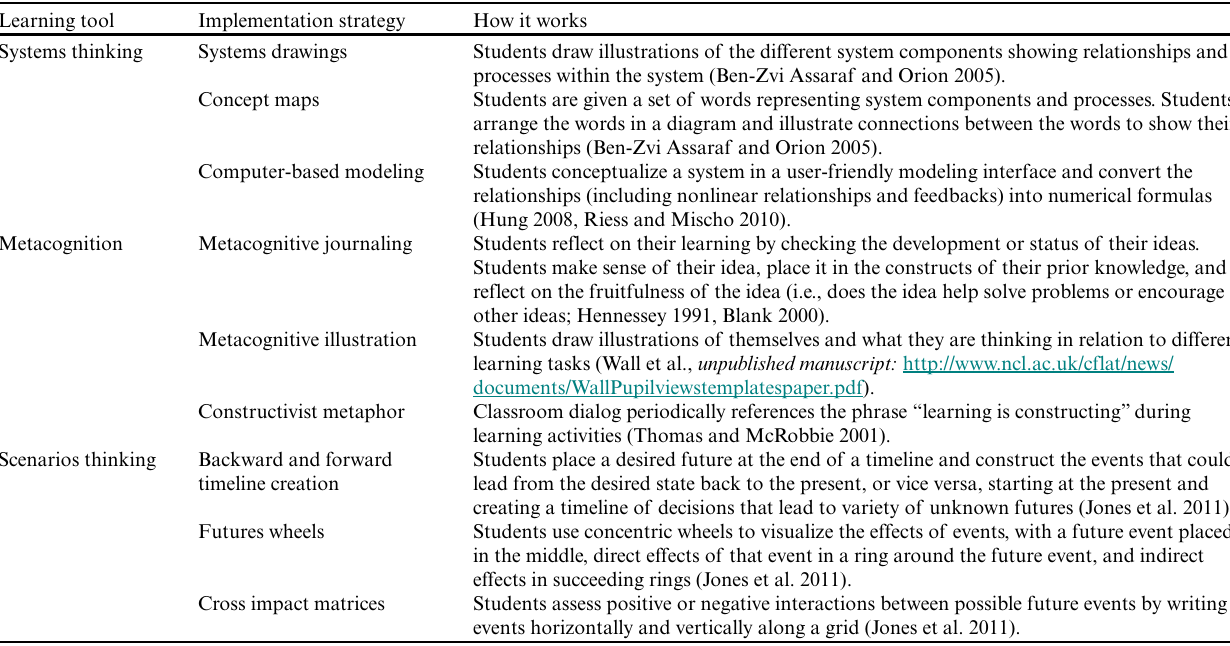
Table 1. Descriptions of some practical implementation strategies for resilience learning tools in K–16